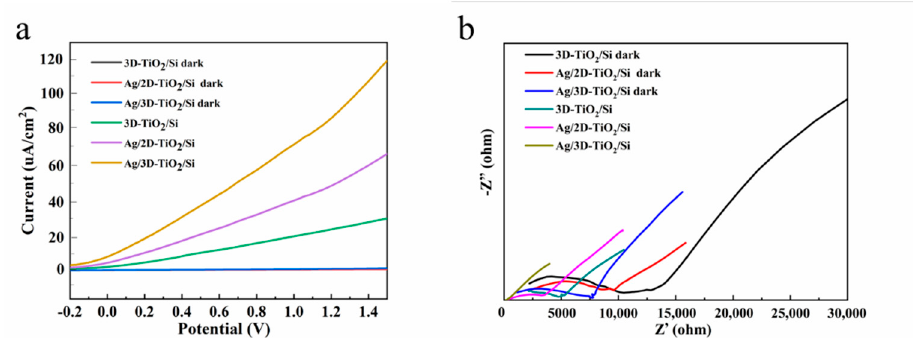
Figure 7. ( a ) LSV and ( b ) electrochemical impedance spectroscopy of different substrates.